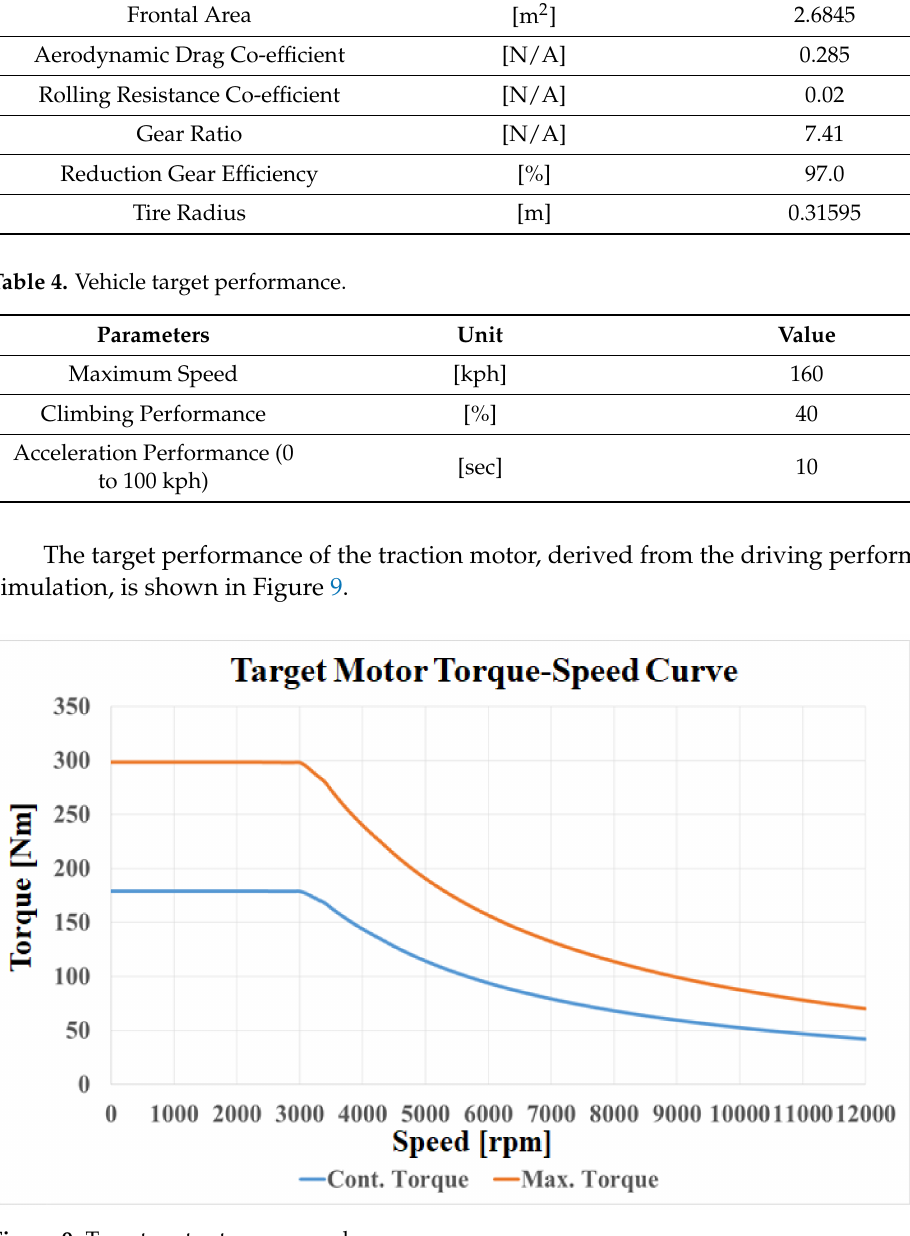
Figure 9. Target motor torque-speed